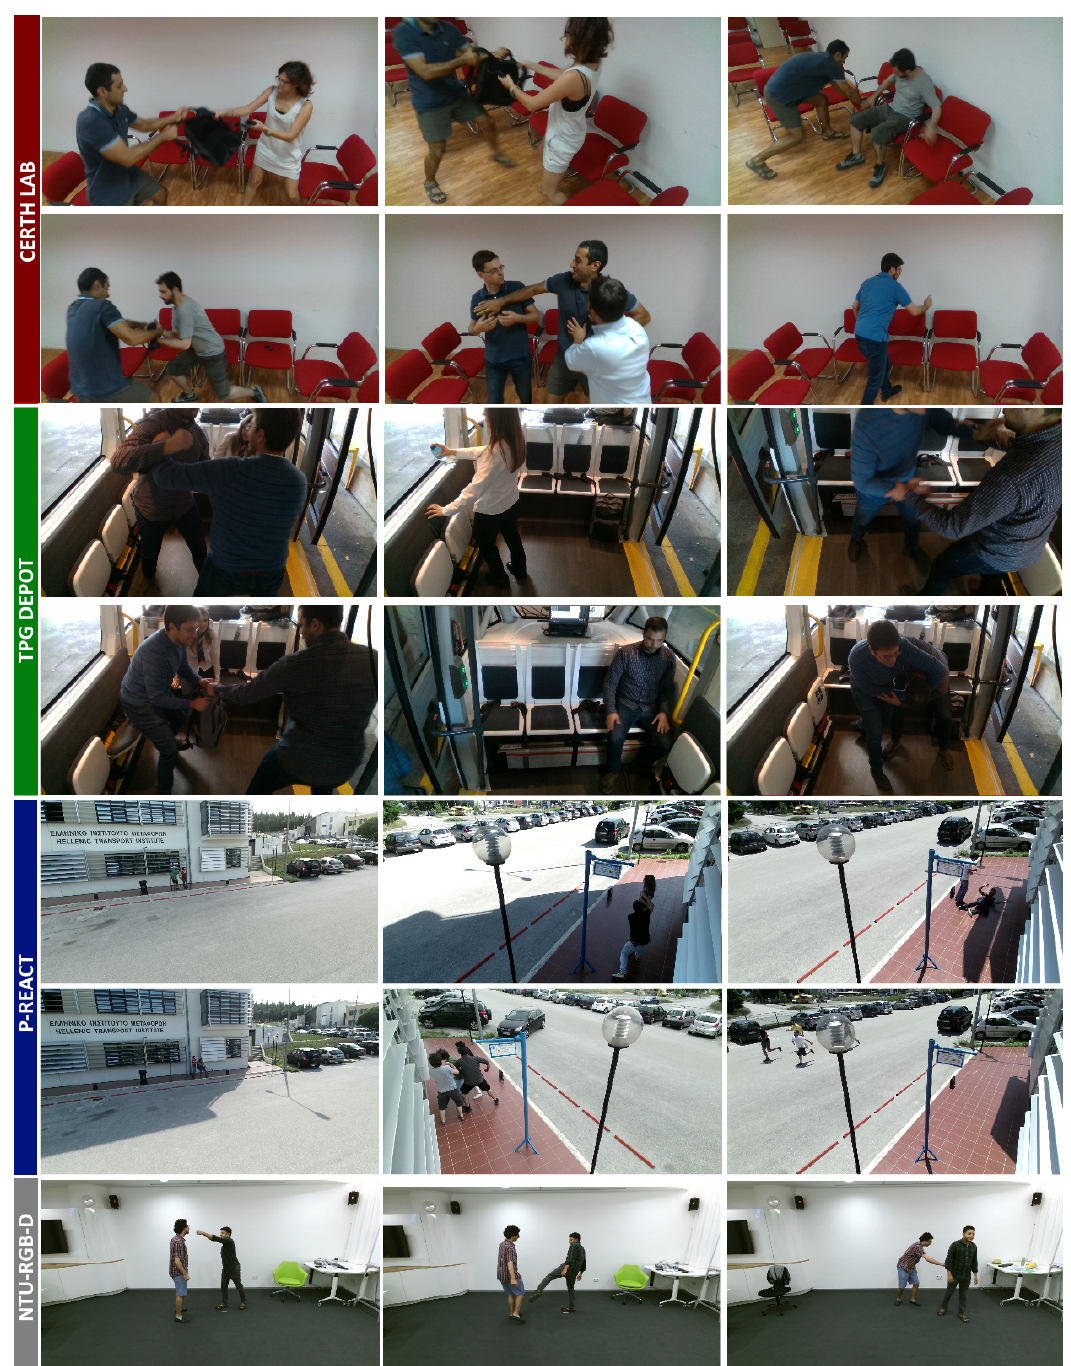
Figure 1. Dataset samples with abnormal events which showcase the use cases. Fighting, aggression, bag-snatching, and vandalism scenarios are illustrated. The red section contains simulated data in lab, green section depicts captured data from TPG shuttles, blue section shows scenarios from P-REACT dataset, and the gray section indicates additional data imported from the NTU-RGB